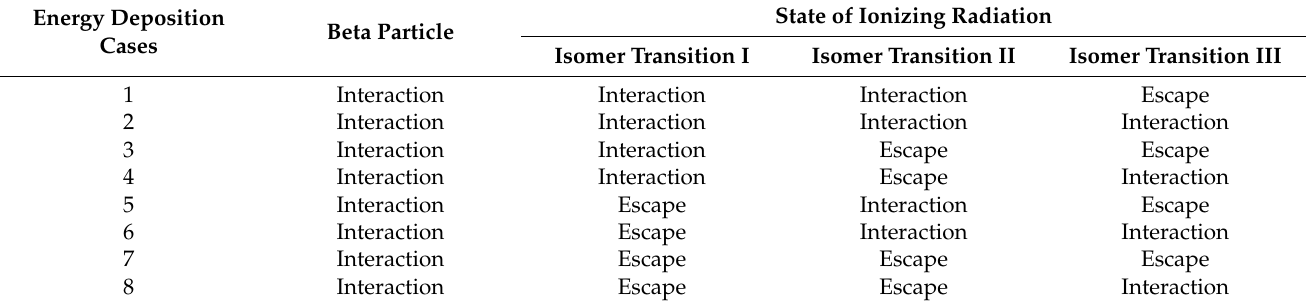
Table 2. The cases of energy deposition by the state of ionizing radiation from the isomer transition. Energy